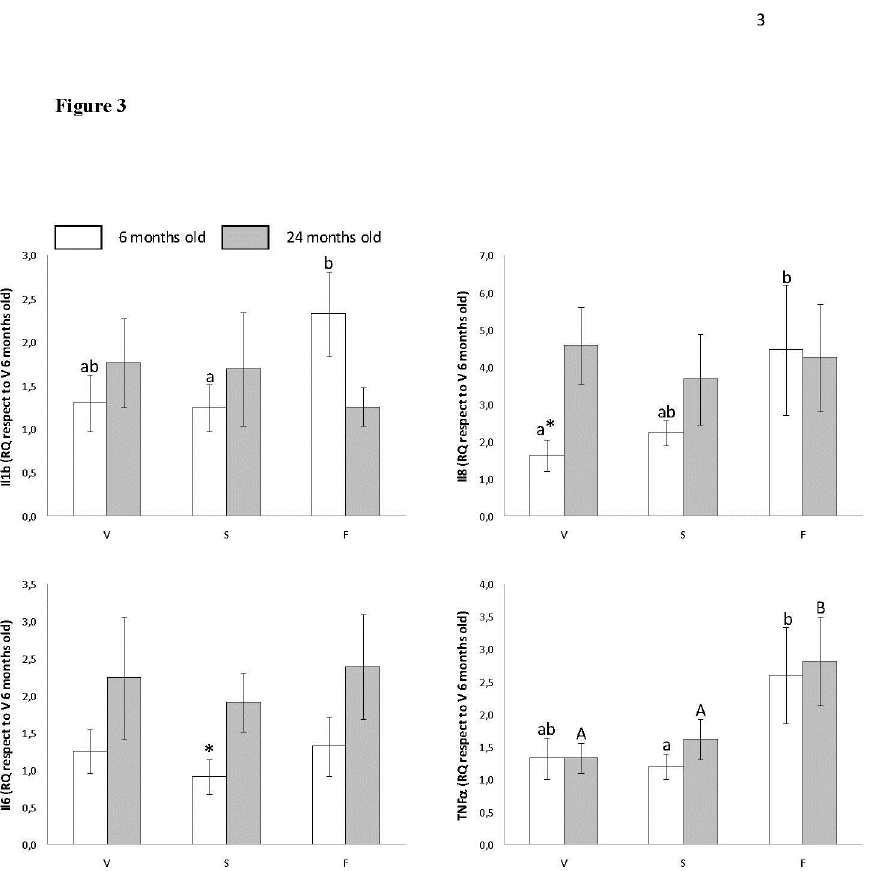
Figure 3. Effects of dietary fat type on Interleukin-related mRNA levels in gingival tissue of young (6 months old) and old (24 months old) rats fed on virgin olive (V), sunflower (S) or fish (F) oils. Results are presented as mean ± EEM. Asterisk (*) means a statistically significant difference between the same dietary treatment for rats aged 6 and 24 months. Lower-case letters, when different, represent statistically significant differences ( P < 0.05) between the three dietary treatments at 6 months. Upper-case letters, when different, represent statistically significant differences ( P < 0.05) between the three dietary treatments at 24 months. doi: